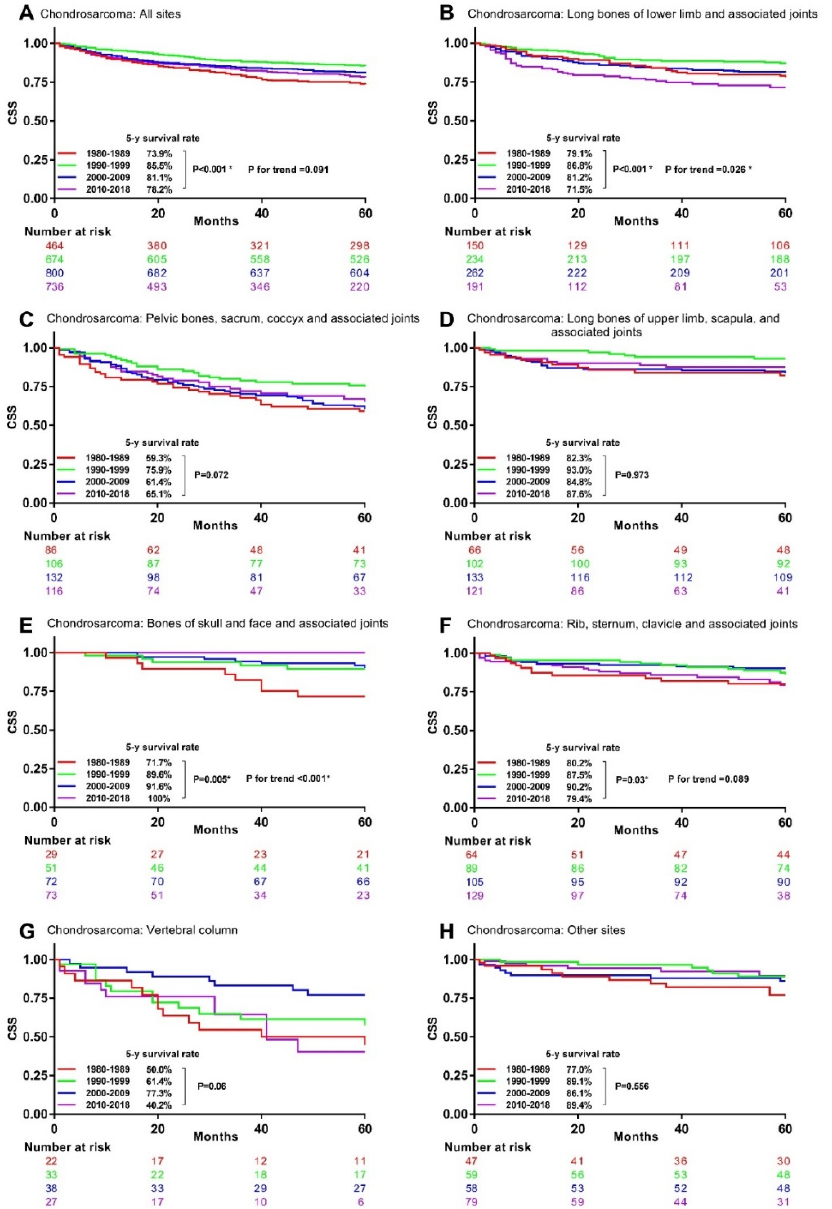
Figure 4. Kaplan–Meier curves showing 5-year CSS rates trend by decade in chondrosarcoma with different primary sites. CSS: bone sarcomas-specific survival. * Statistically significant. ( A ), All site ( B ), Long bones of lower limb and associated joints ( C ), Pelvic bones, sacrum, coccyx and associated joints ( D ), Long bones of upper limb, scapula, and associated joints ( E ), Bones of skull and face and associated joints ( F ), Rib, sternum, clavicle and associated joints ( G ), Vertebral column ( H ) Other sites. The univariable analysis for Ewing sarcoma patients indicated that their 5-year CSS rates significantly increased from 49.6% in the 1980s to 58.1% in the 1990s, 65.9% in